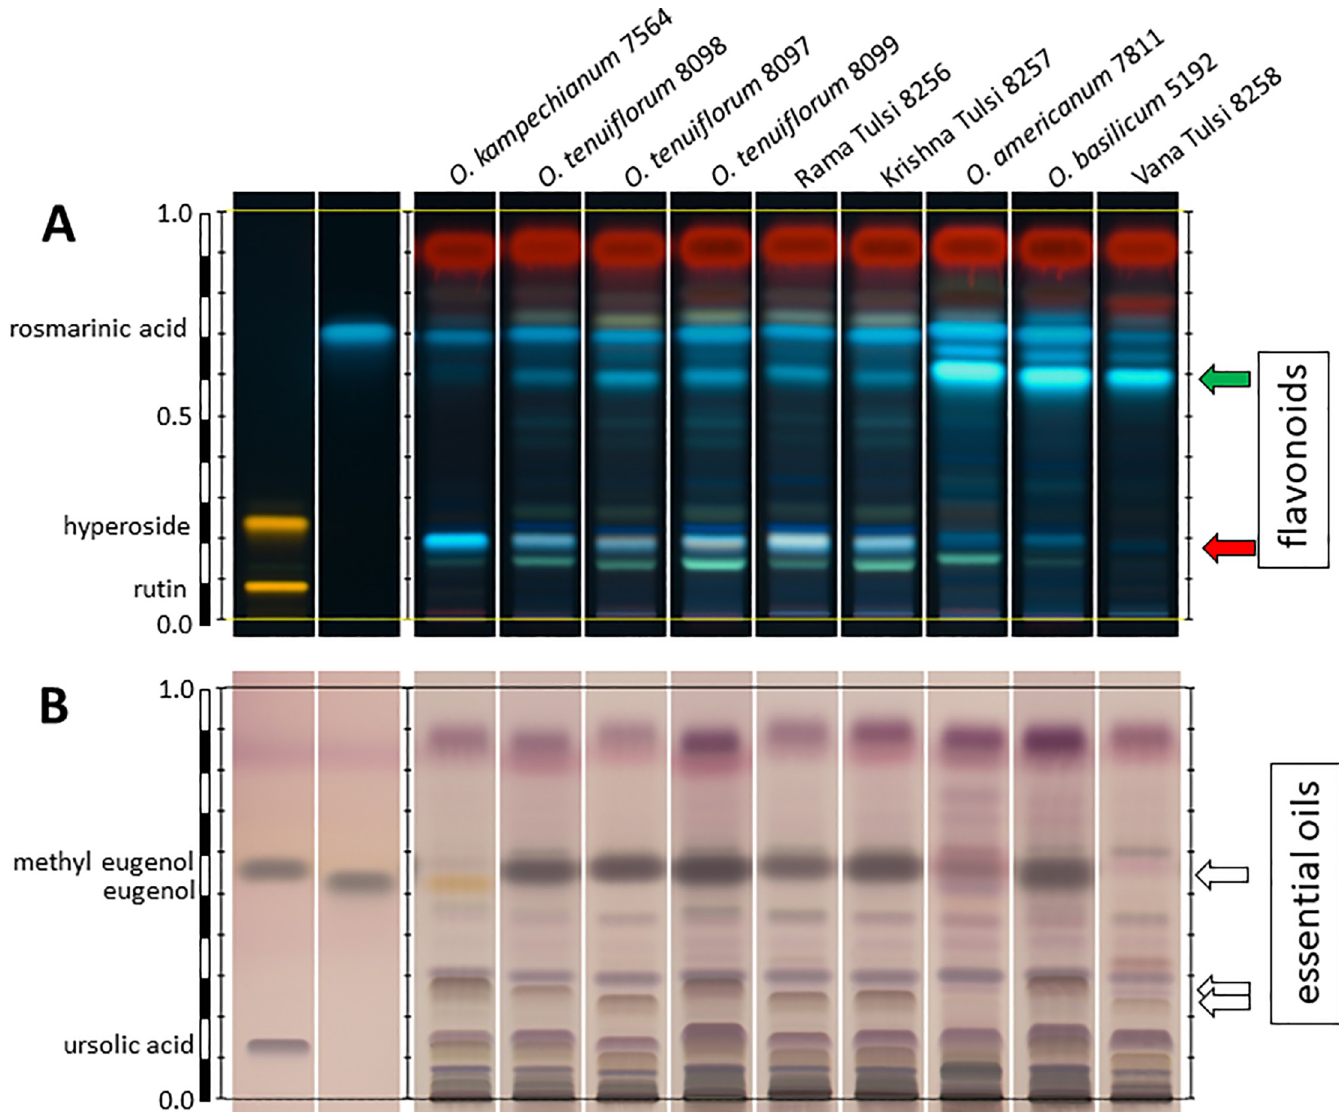
Fig 4. Chemical profiling of different Ocimum accessions raised side by side in the greenhouse under white light over six months. Flavonoids ( A ) and essential oils ( B ) were probed by HT-TLC along with reference standards (in case of flavonoids, rutin and hyperoside, in case of essential oils methyl eugenol and ursolic acid). Arrows indicate type-specific bands, green arrow indicates a prominent band in the flavonoid band that is characteristic for accessions belonging to haplotype I in Fig 3, while red arrow indicates a flavonoid band that is characteristic for accessions belonging to haplotype II and IV accessions in Fig 3